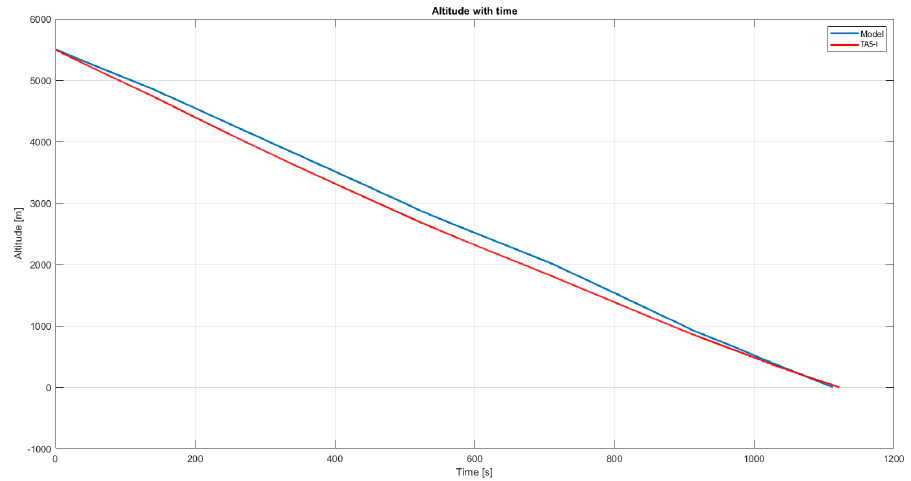
Figure 8. Descend rate comparison with the TAS − I drop test